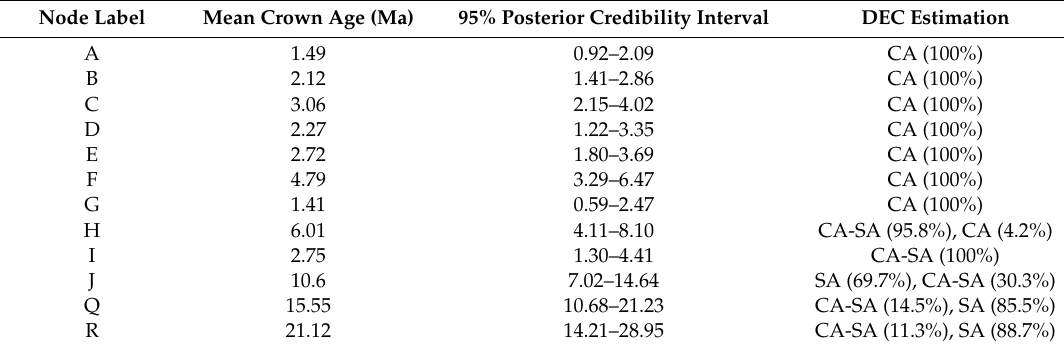
Table 3. Estimated crown ages (in millions of years ago, Ma) and results of the ancestral area estimation using the Dispersal-Extinction-Cladogenesis (DEC) model for the species of Atelopus of Central America and other selected nodes within the genus. Ages were estimated by concatenated MCMC Bayesian analyses using the software BEAST 2. See text for details. Node labels are indicated on the tree in Figure 3. CA = Central America, SA = South